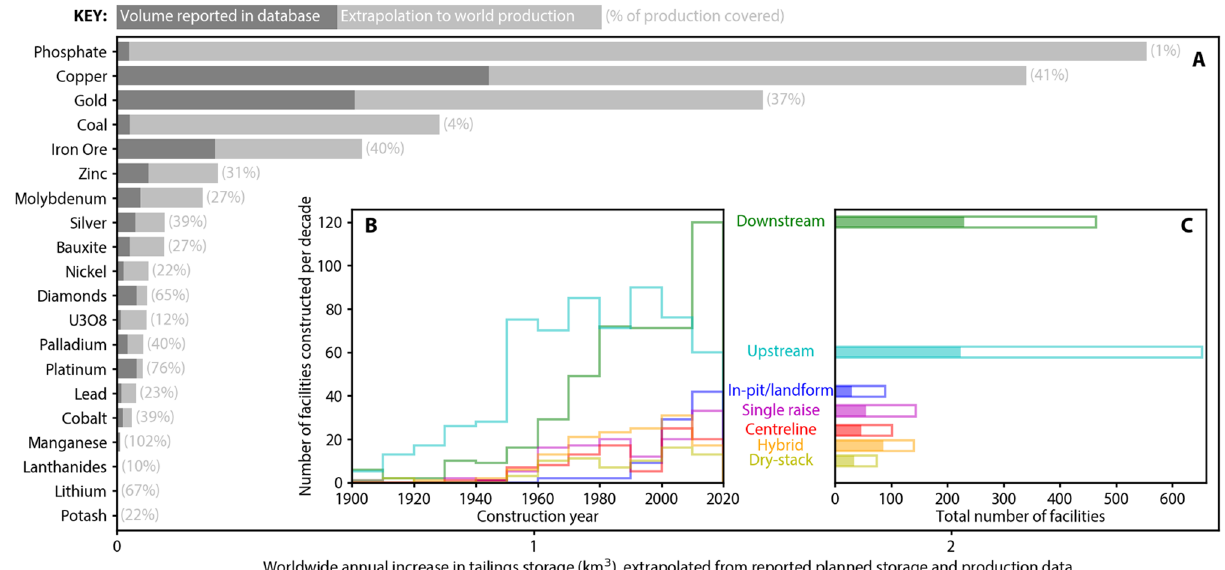
Figure 1. Tailings storage. ( A ) Tailings storage volume increase per year over the 2019–2023 period for a range of commodities as reported in the dataset and extrapolated to world production. ( B ) Number of